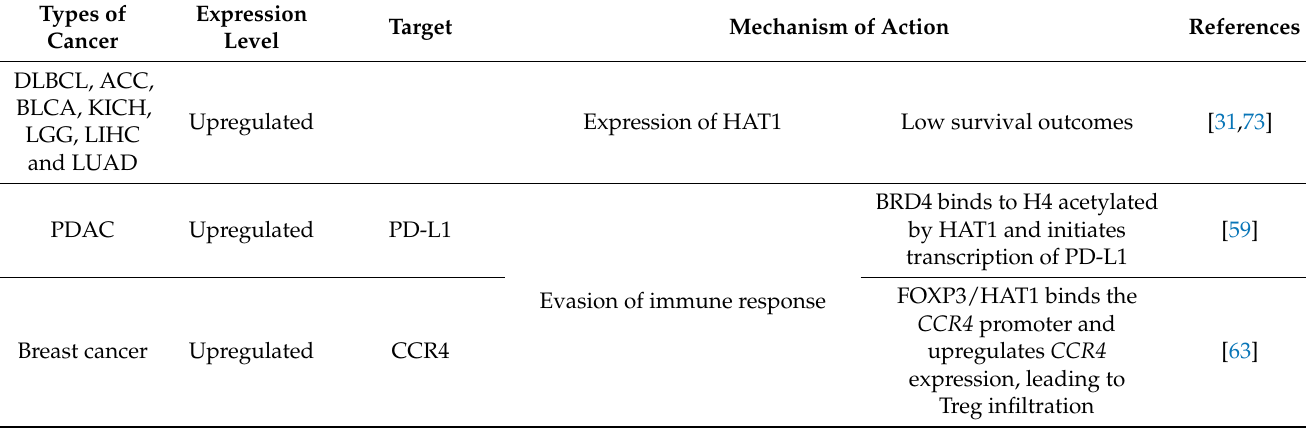
Table 1. HAT1 expression levels, divided by upregulation or downregulation, and functions in different types of